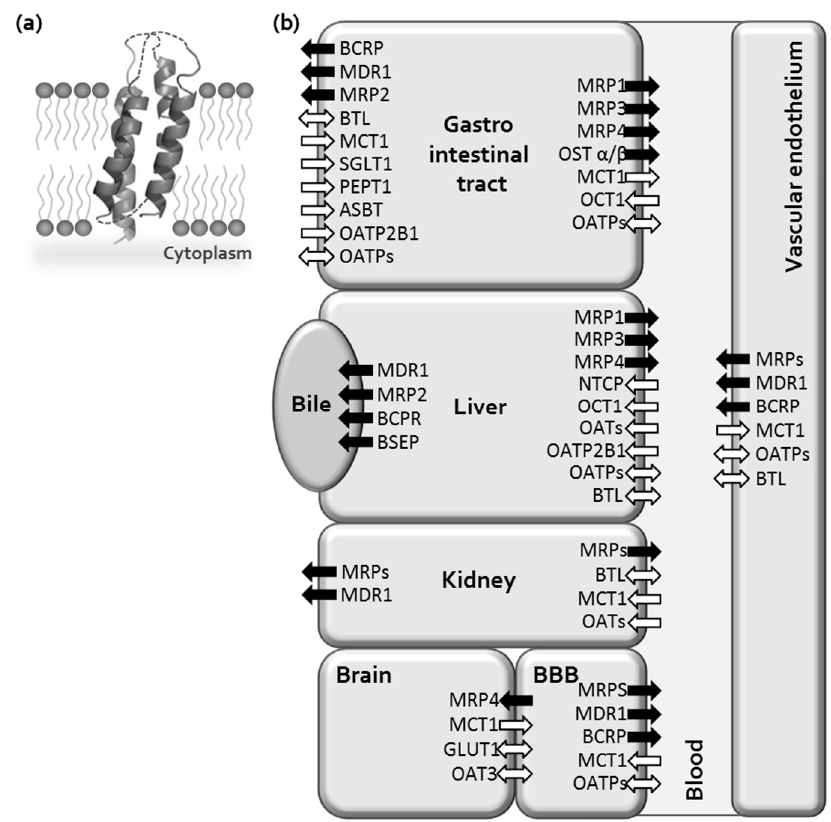
Figure 2. ( a ) Structural model of membrane transporter bilitranslocase (top-scoring computational arrangement of four transmembrane helices based on NMR spectroscopy data) [62]. No homologs were defined for 1026 bp mRNA sequence (GenBank: Y12178.1), thus the comparative modeling studies are not possible to perform. The further structure characterization of bilitranslocase is under study. ( b ) Scheme of cell membrane transporters distribution in different tissues [44,50,58]. ABC transporters are indicated by black arrows and solute carriers (SLC) by white arrows; one direction transport (one way arrow), bidirectional transport (two way arrow).